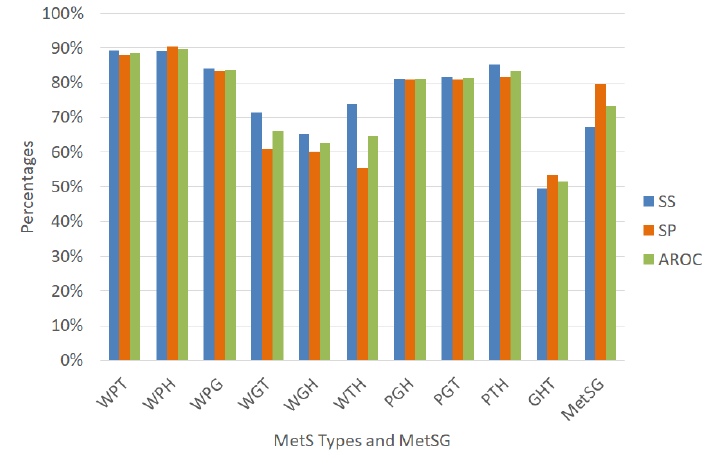
Figure 8. Performance indicators of the RusBoost for the MetS types using the original dataset.